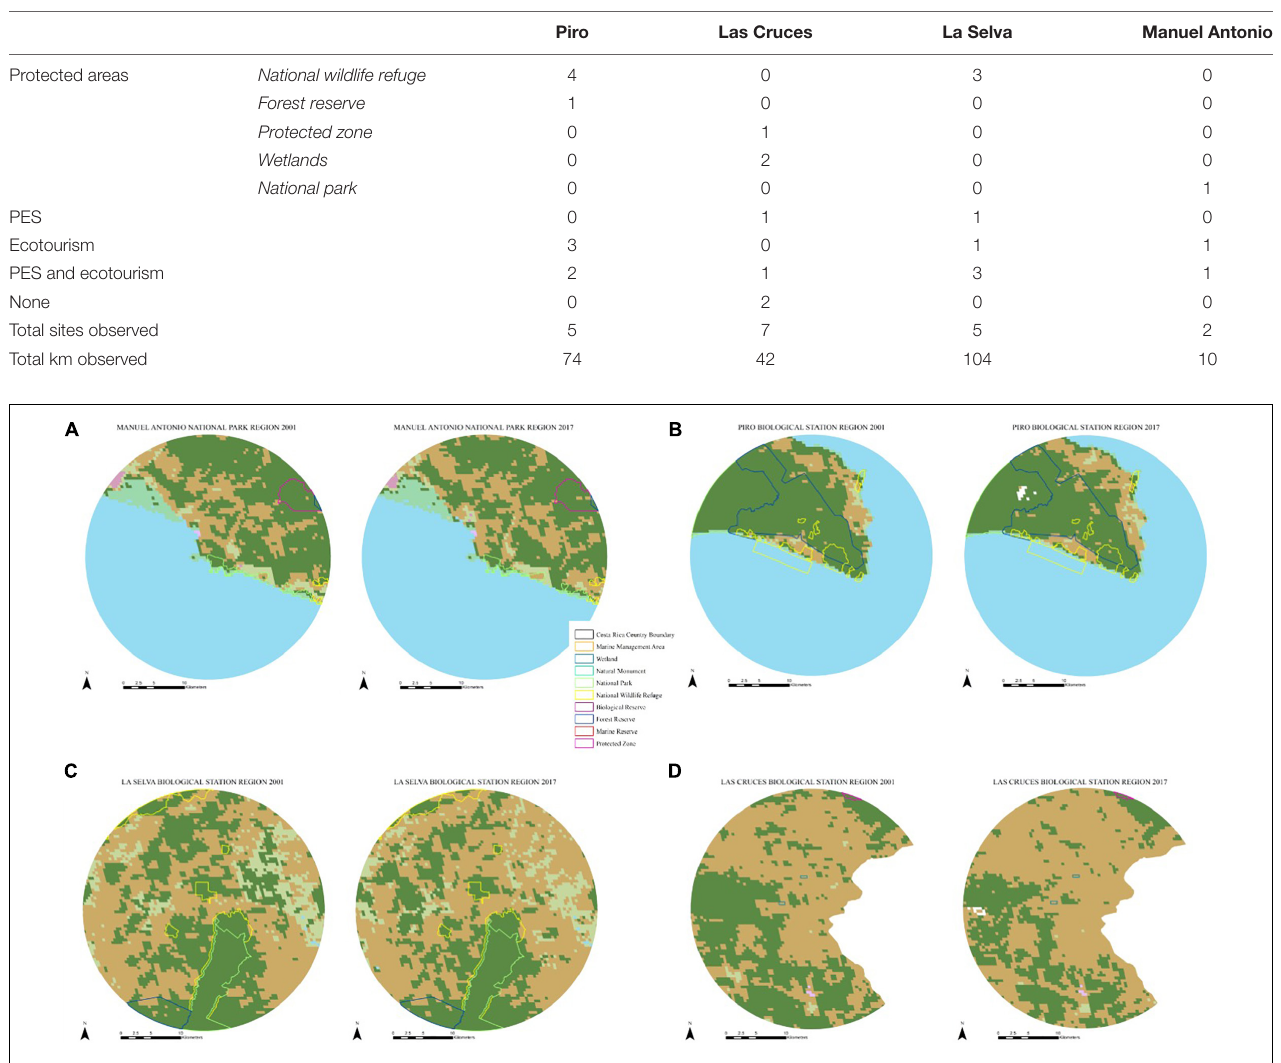
FIGURE 2 | Land cover and protected areas in 2001 and 2017 for (A) Manuel Antonio, (B) Piro, (C) La Selva, and (D) Las Cruces regions in Costa Rica used to calculate deforestation rates inside and outside of protected areas for each